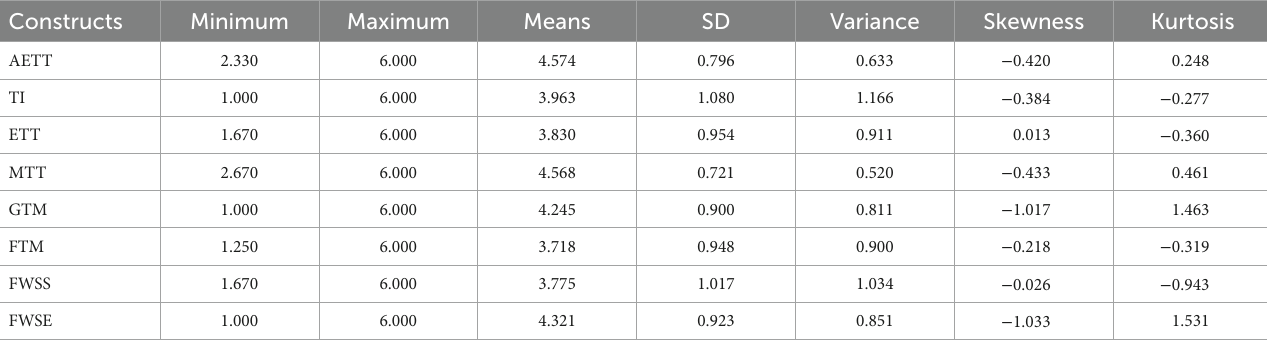
TABLE 6 Descriptive analysis of each